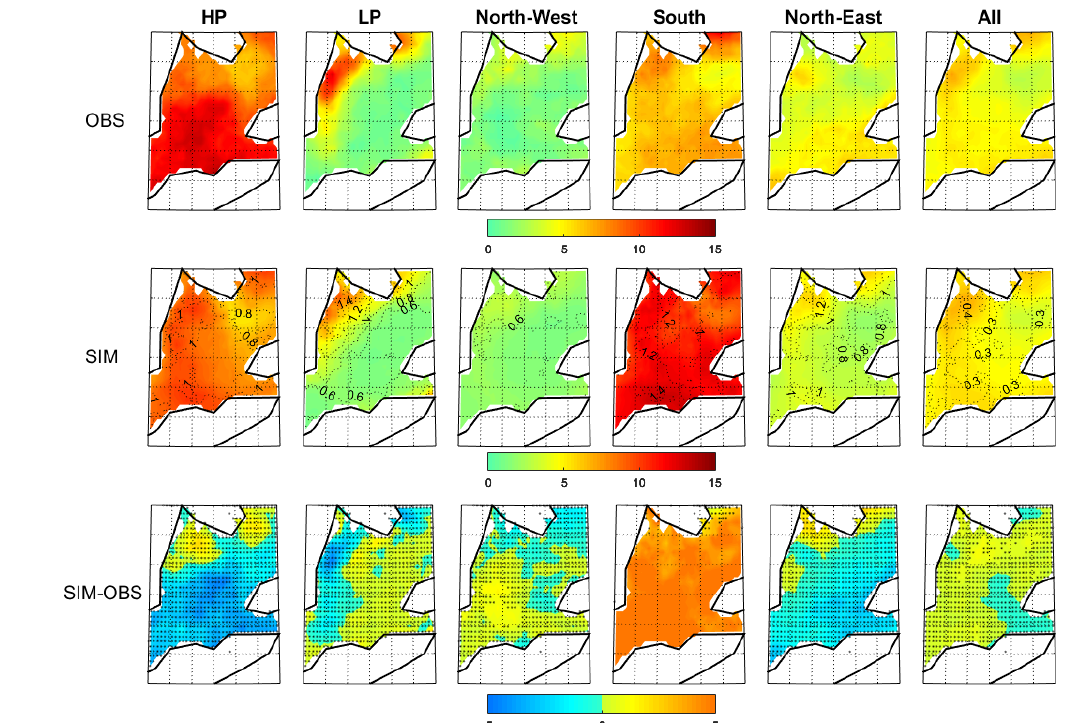
Figure 4. Percentage of DJF number of precipitation events ( P > 10mm) relative to DJF occurrence of weather regimes in the historical pe- riod (1961–1990) for the observations (upper panels), simulations from the CRCM5-LE 50-member average (middle panels) and simulations minus observations (lower panels). The dotted lines in the middle panels represent the standard deviation of the 50-member CRCM5-LE simulated percentage. Stippled regions in the lower panels indicate where the observations lie within the CRCM5-LE ensemble